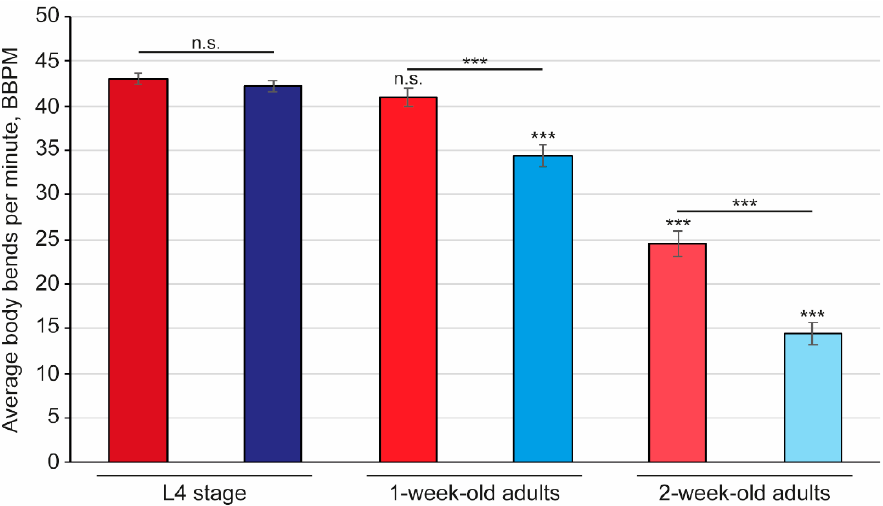
Figure 2. The number of body bends reduced with worm age, with a more pronounced effect in the worm model for Parkinson’s Disease. The number of body bends per minute were assessed in wild-type (red bars; strain, N2 ) and worms expressing the human α -synuclein in body wall muscle (blue bars; strain, NL5901 ) animals at L4, 1 week (L4 + 7 days), and 2 weeks (L4 + 14 days) of age. Counts were assessed using wRMTrck in ImageJ and averages plotted with the standard error of the mean (s.e.m.). Statistical analysis used the 2-tailed 2-sample t -test where *** indicates a p value of p < 0.001 when comparing the same strain to L4, or as indicated, and n.s. designates not significant. N ≥ 60 over 3 independent replicates.